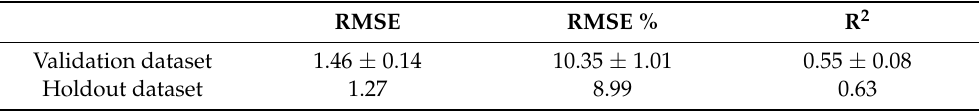
Figure 5. Machine learning model predictions of hybrid yield on the holdout dataset (2017—2019) based on genotype and crop management data. ( a – c ) show the predicted yield (t/ha) in the y-axis in comparison to the ground-truth yield (t/ha) in the x-axis for each sample in the holdout dataset. ( d – f ) present the model prediction error per treatment, the error value was obtained by subtracting the predicted yield from harvested yield. ( g – i ) show the percentage of hybrid plots classified as high, medium and low yield. The x-axis shows the predicted labels, and the y-axis is the ground-truth label. Table 3. Yield prediction performance of sp-DNN using multispectral features. The validation dataset values were obtained through fivefold cross-validation and presented with standard